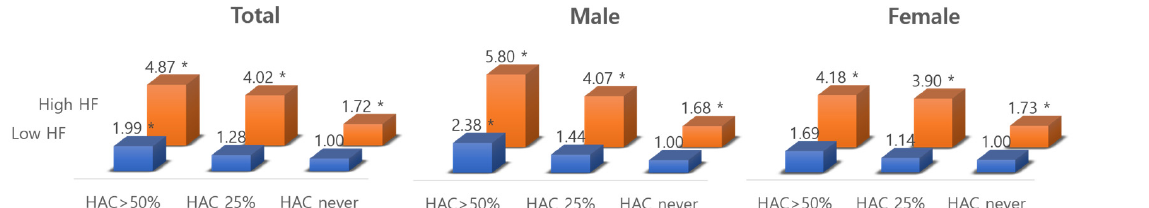
Figure 2. The interactive effects of handling angry clients x hiding feelings on mental health, stratified by gender. * p -value below 0.05 for adjusted odds ratio.